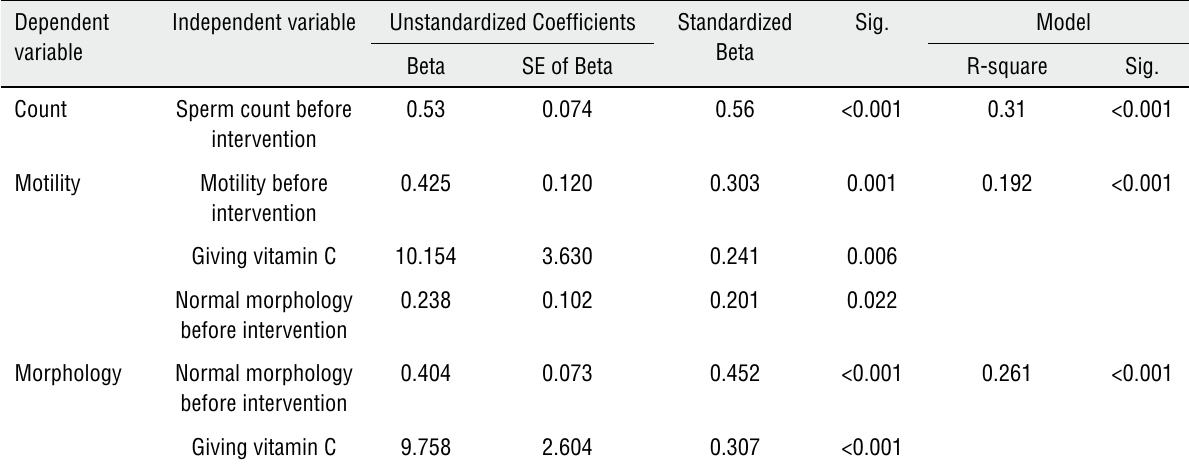
Table 4 – Stepwise linear regression model of post-surgical indices of semen analysis. Dependent